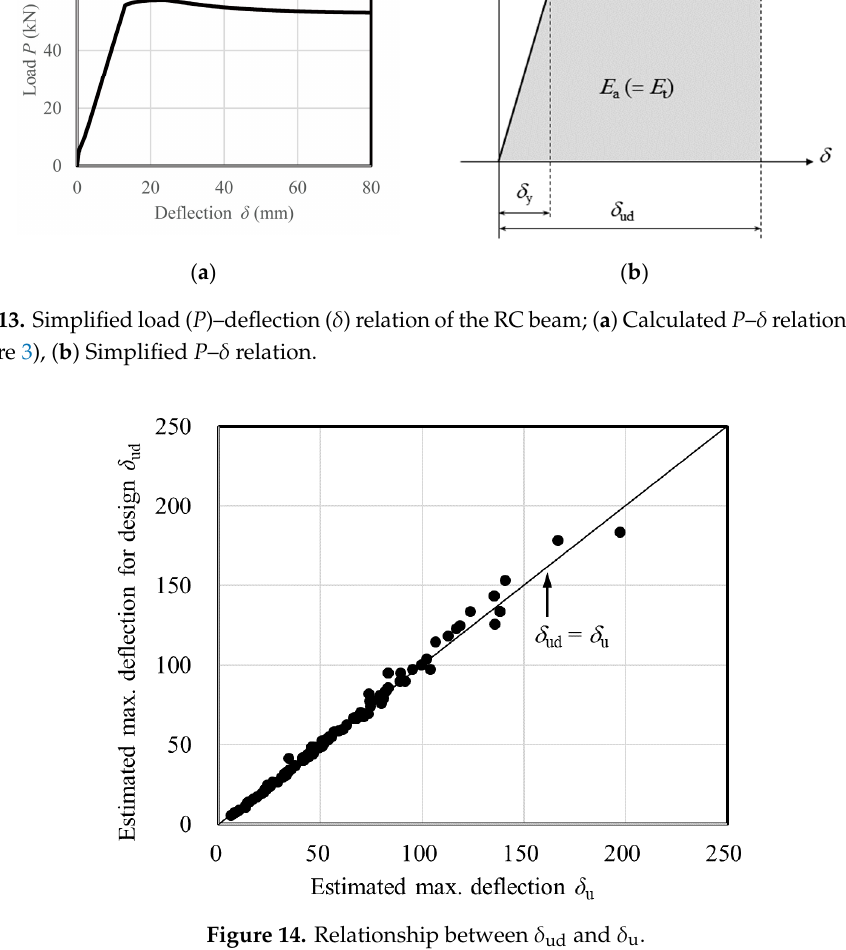
Figure 14. Relationship between δ ud and δ u .